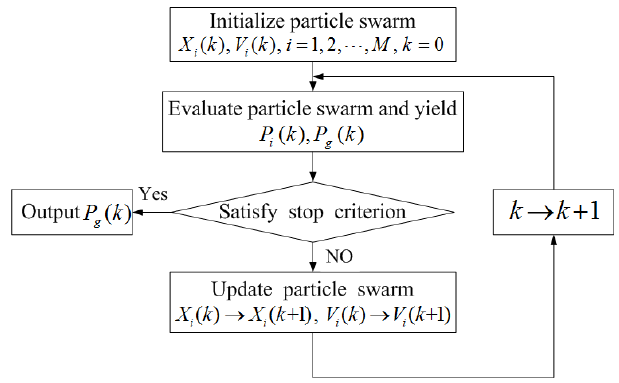
Figure 3. The flow chart of the PSO algorithm. points and, for the mesh points inside the region, the predic- tion error caused by each initial error can be obtained. The CNOP refers to the mesh point which leads to the largest prediction error (Duan and Luo, 2010). Since the accuracy of the CNOP generated by the filtering method depends on the division size of the constraint region exclusively, the circum- scribed squares of the constraint ball of CNOPs are separated into 1001 × 1001 small quadrate patches with very small side length 1 . 6402 × 10 − 5 in numerical experiments. For a de- tailed description of the operation of the filtering method, one can refer to Duan and Luo (2010) and Zheng et al.